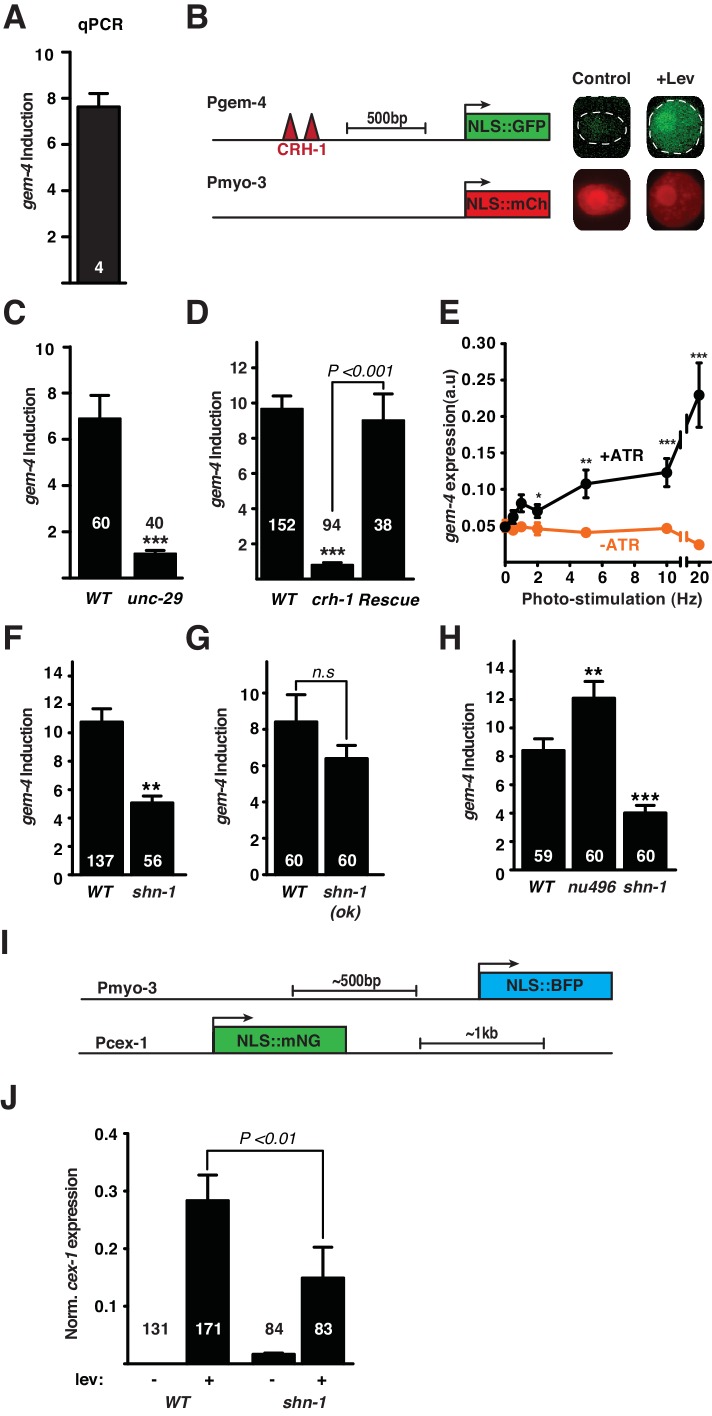
gem-4 Copine expression in body muscle is induced by depolarization.Induction of gem-4 expression was analyzed by qPCR (A) and using a transcriptional reporter (B–H). (A) The abundance of gem-4 mRNA (assessed by qPCR) was increased following 1 hr levamisole (Lev) exposure. The number of biological replicates is indicated. (B) A schematic diagram of the gem-4 reporter construct (left) and representative images of muscle nuclei (right) before and after a 20 min Lev exposure, and 2 hr recovery. (C–D) The mean fold induction of the gem-4 reporter (Pgem-4) after Lev treatment is shown. Lev-induced gem-4 expression was abolished in mutants lacking UNC-29, an essential subunit of the Lev receptor (C) and in mutants lacking the transcription factor CRH-1 (D). The crh-1 mutant defect in gem-4 induction was rescued by a transgene expressing CRH-1 in body muscles (D). (E) Expression of the gem-4 reporter was measured following photo-stimulation of transgenic animals that express ChR2 in cholinergic motorneurons. Expression of gem-4 was significantly increased by 2, 5, 10, and 20 Hz photo-stimulation (for 20 min). Photo-evoked gem-4 expression was not observed when animals were not cultured with ATR. (F–G) The fold induction of the gem-4 reporter following Lev exposure was significantly reduced in shn-1 null mutants (F) but not in shn-1(ok1241) mutants, which lack the PDZ domain (G). Lev-induced gem-4 expression was significantly increased in egl-19(nu496) mutants, which lack the carboxy-terminal PDZ ligand (H). (I–J) Lev induction of the cex-1 reporter is significantly reduced in shn-1 mutants. (I) Schematics of the cex-1 and myo-3 reporters are shown. (J) Expression of the cex-1 reporter (normalized to myo-3 expression in the same nucleus) was significantly increased by Lev treatment. The Lev-induced expression of the cex-1 reporter was significantly reduced in shn-1 mutants. The number of animals analyzed is indicated for each genotype. Values that differ significantly from wild type controls are indicated (***p<0.001; **p<0.01; *p<0.05). Error bars indicate SEM.